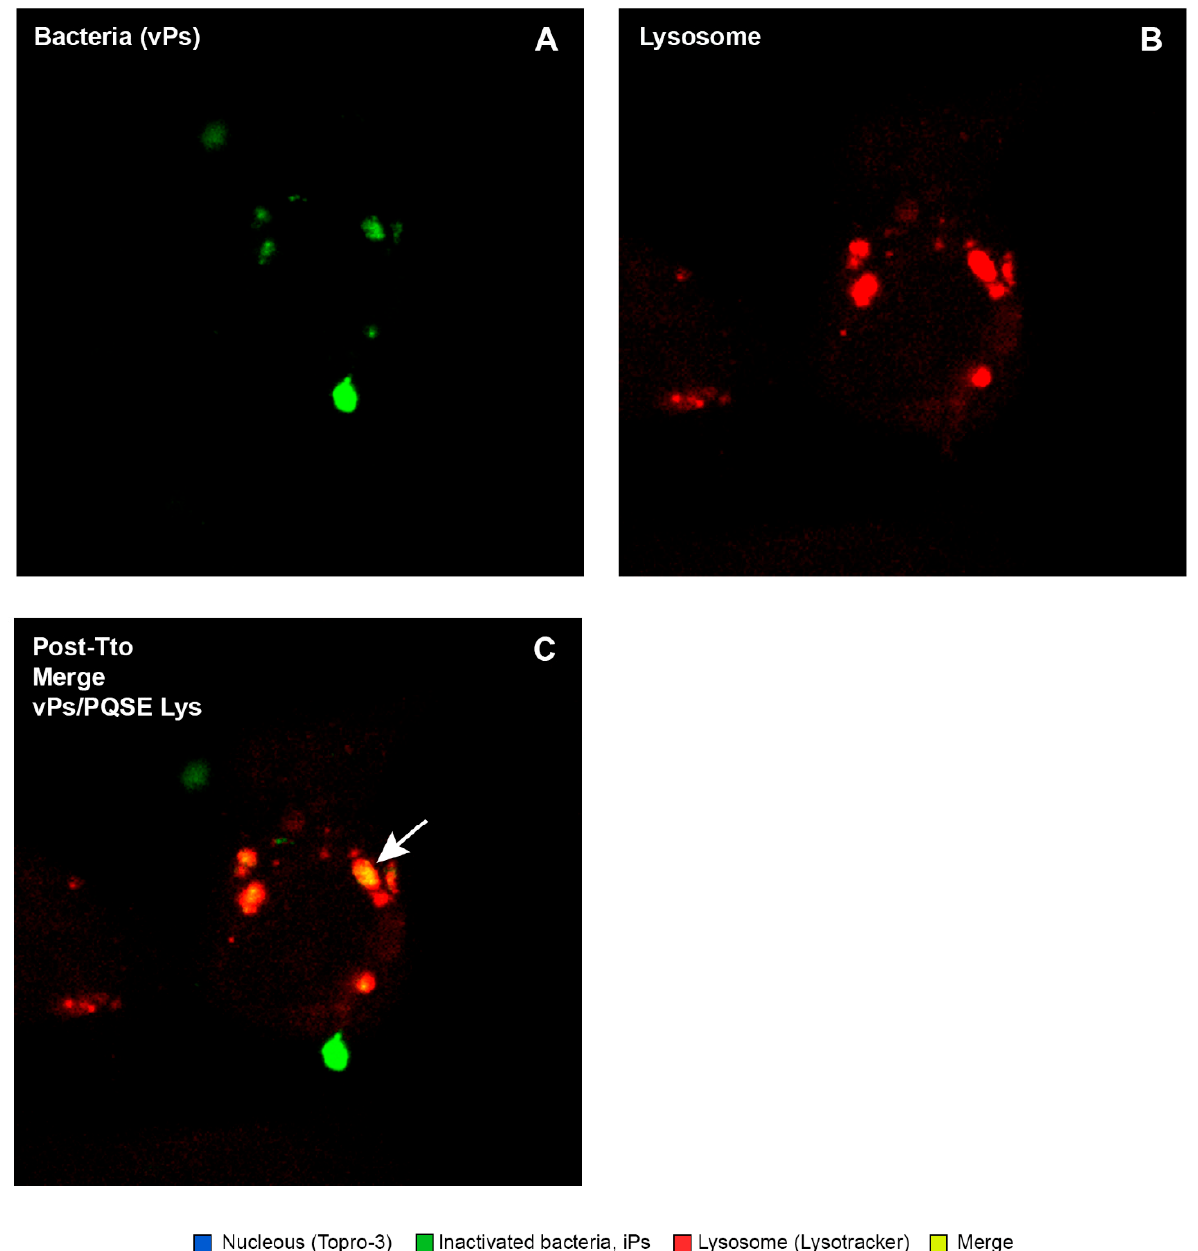
Figure 14. Location of P. salmonis in SHK-1 cells in post-treatment with 0.5 µg/mL of PQSE (24 hpi). The microphotographs show the location of the virulent P. salmonis (vPs) strain LF89 in SHK-1 cells treated with PQSE, 3 h after challenge with vPs. ( A ) The nuclei of the cells marked with TOPRO-3 (blue) can be observed. ( B ) Virulent bacteria (vPs) (green) can be observed. ( C ) The Lysotracker Red-labeled Lysosomes can be observed (red), and ( D ) vPs bacteria located inside lysosomes were observed to be orange-yellow as an indicator that there was maturation of the phagosome that contained the bacterium and phagosome–lysosome fusion.